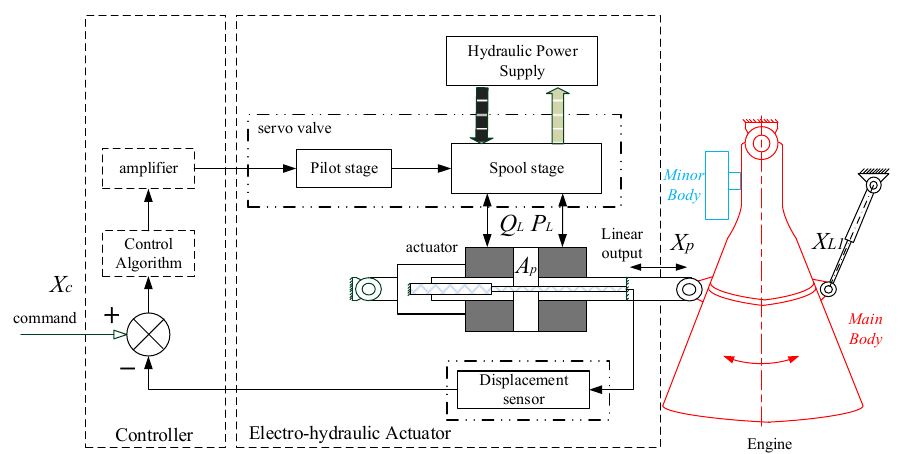
Figure 2. The simplified schematics for an aerospace electro-hydraulic actuation system. For the high-order engine body’s structural dynamics, a baseline two-mass-two-spring model was presented in Figure 3, where M 1 , K L 1 , B L 1 , X L 1 and M 2 , K L 2 , B L 2 , X L 2 are the equivalent mass, spring stiffness, viscous coefficient, linear displacement of the main engine body and the minor body, respectively, and the connected hydraulic actuator is given together. Figure 3. The physical model of the hydraulic actuator and the driven kerolox engine. The mathematical equations are presented in Laplace-form Equations (1)–(7).